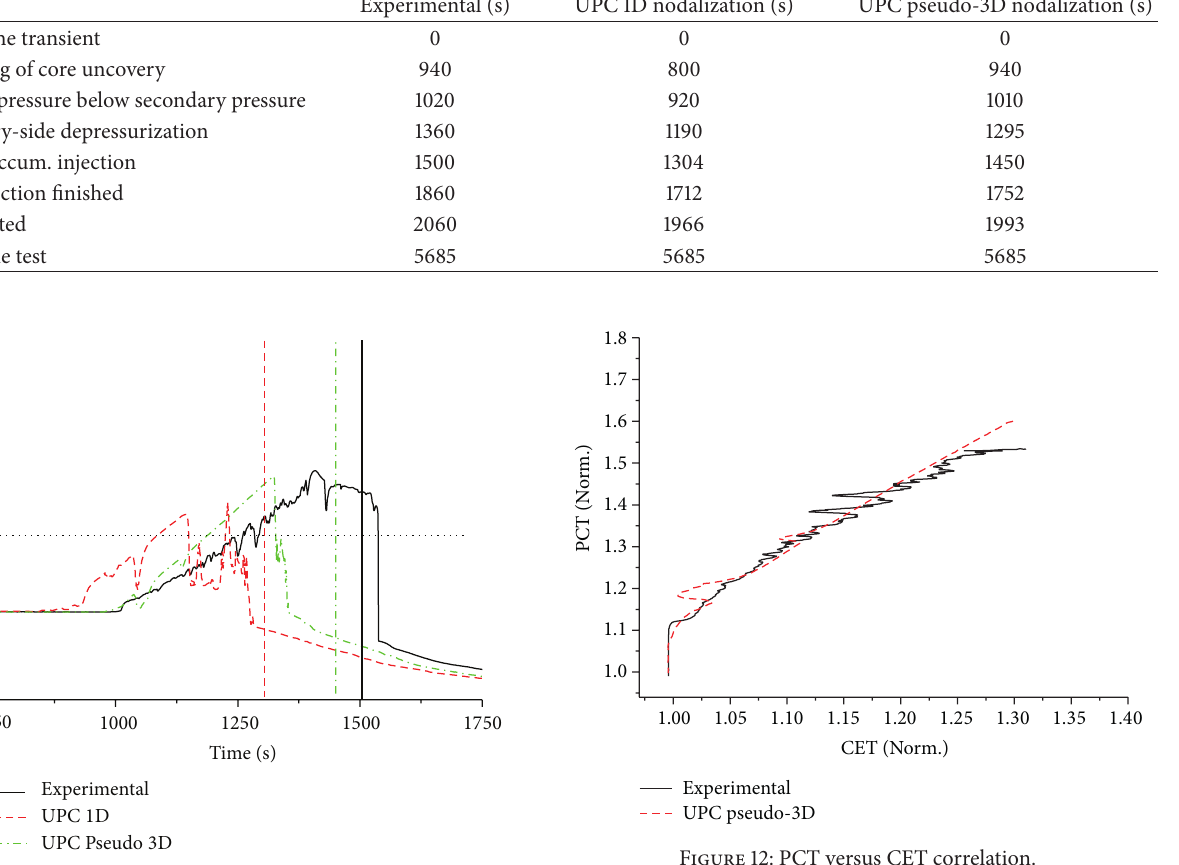
Figure 11: Core exit temperature.